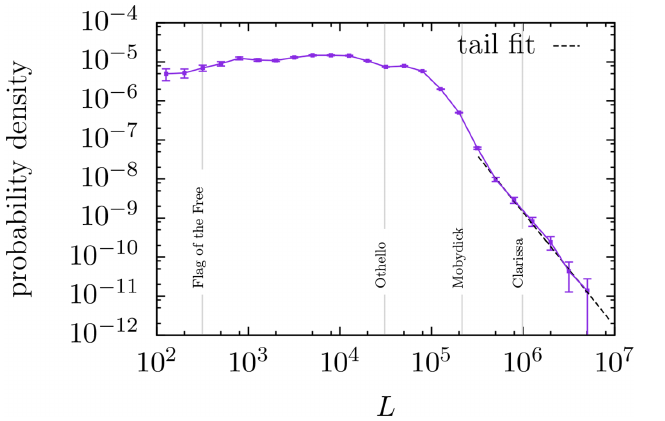
Fig 1. Estimation of the probability density function of text length L in the English Project Gutenberg database, using logarithmic binning (5 bins per decade). Texts with less than 100 tokens are not considered. A power-law fit of the tail [34] yields an exponent 2.92 ±